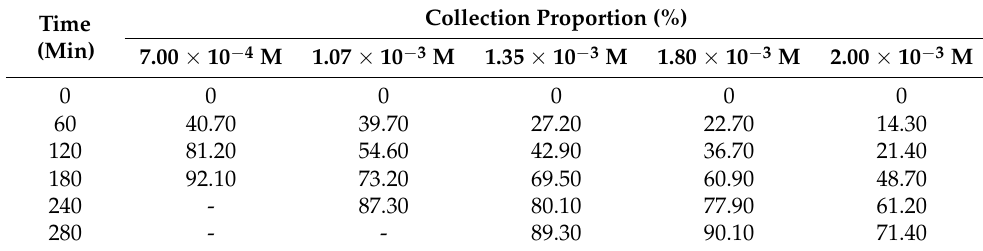
Table 1. Influence of Ho(III) Co